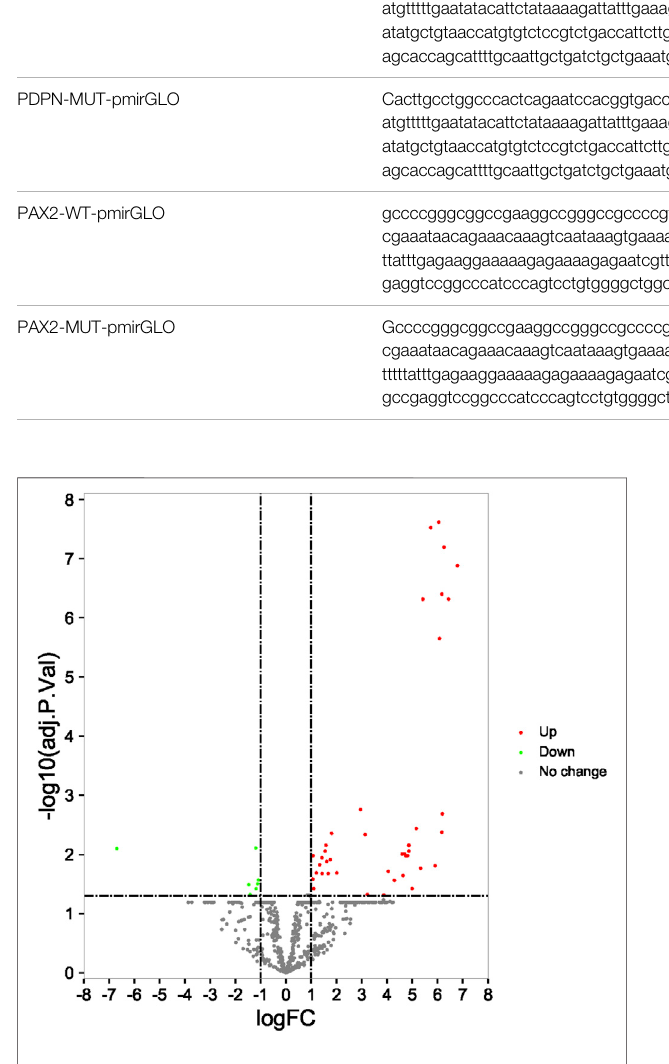
FIGURE 2 | Identi fi cation of differentially expressed miRNA in pro fi le datasets. The 49 differentially expressed miRNAs in